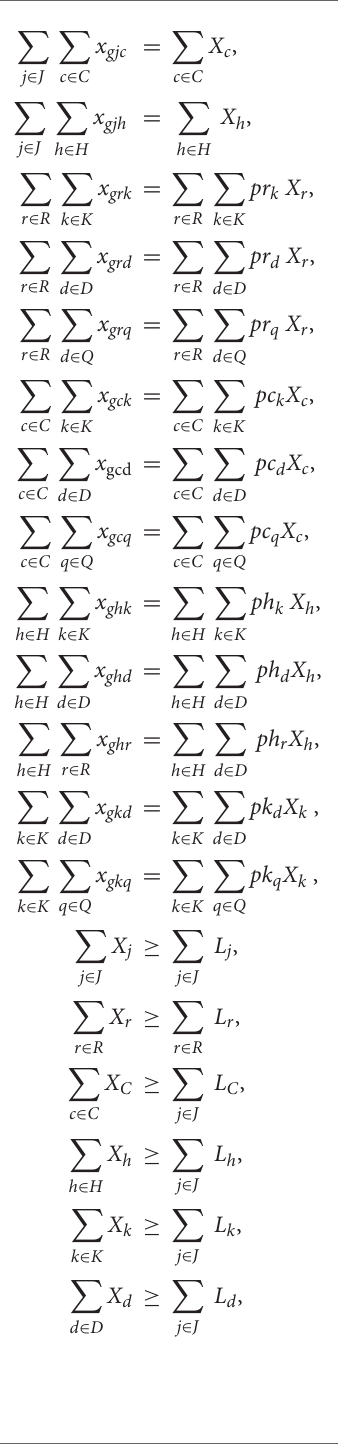
TABLE 2 | Objective function